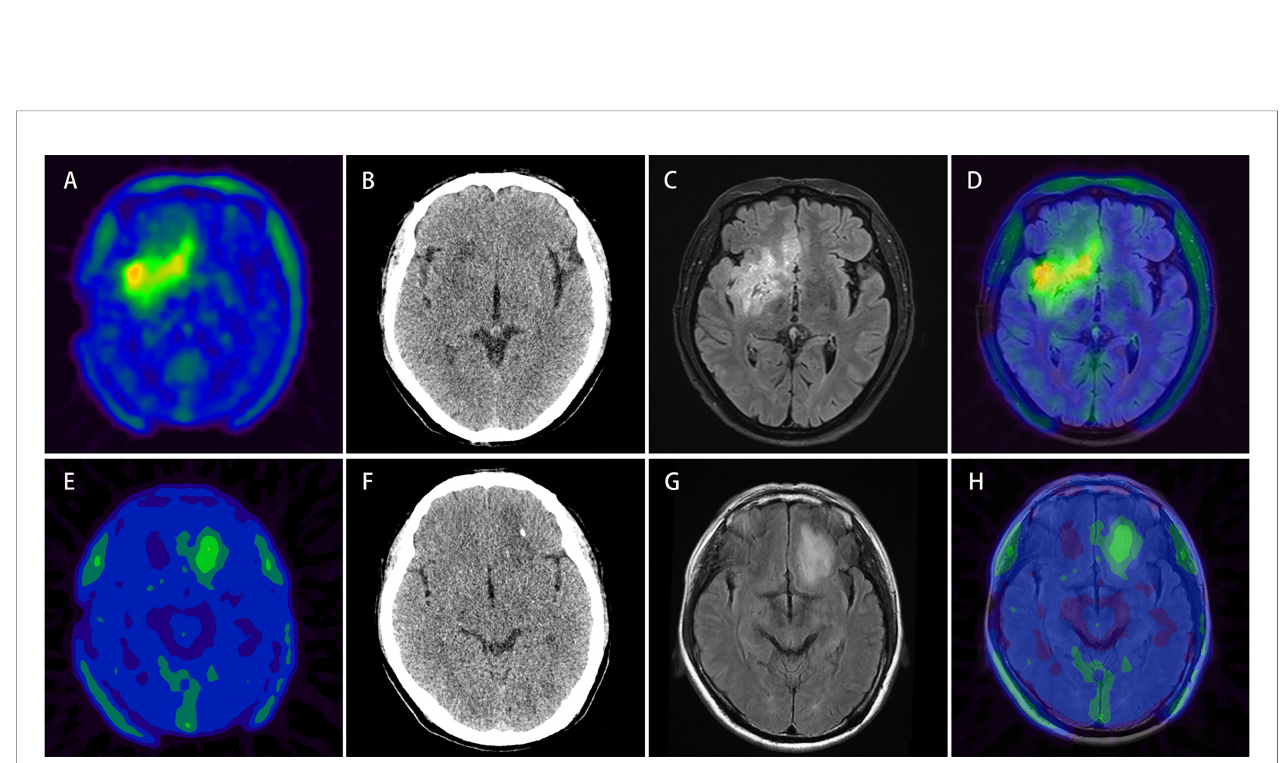
FIGURE 7 | Upper row: example of a patient (patient No. 2) with 18 F-FET lesion in the right frontotemporal-insular lobe in fi ltrating the brain midline structure (A) relatively more intratumoral heterogeneous imaging with a SUV SD of 0.32 (> 0.23) and calculated-scores for the four predictive models (simple model, PET-Rad model, CT-Rad model and PET/CT-Rad model) were -2.07, -1.82, -1.19, and -3.02. (B) Corresponding low dose CT image of the patient (C, D) T2 FLAIR MRI and PET/MR fused image; histopathological analysis revealed a WHO grade II diffuse astrocytoma, IDH -wildtype. Lower row: example of a patient (patient No. 28) with 18 F-FET lesion in the left frontal lobe without brain midline structure involvement (E) relatively less intratumoral heterogeneous imaging with a SUV and calculated-scores for the 4 predictive models were 0.42, 0.18, 1.80, and 0.53 (F) Corresponding low dose CT image of the patient (G, H) T2 FLAIR MRI and PET/MR fused image; histopathological analysis revealed a WHO grade II diffuse astrocytoma, IDH -mutant.